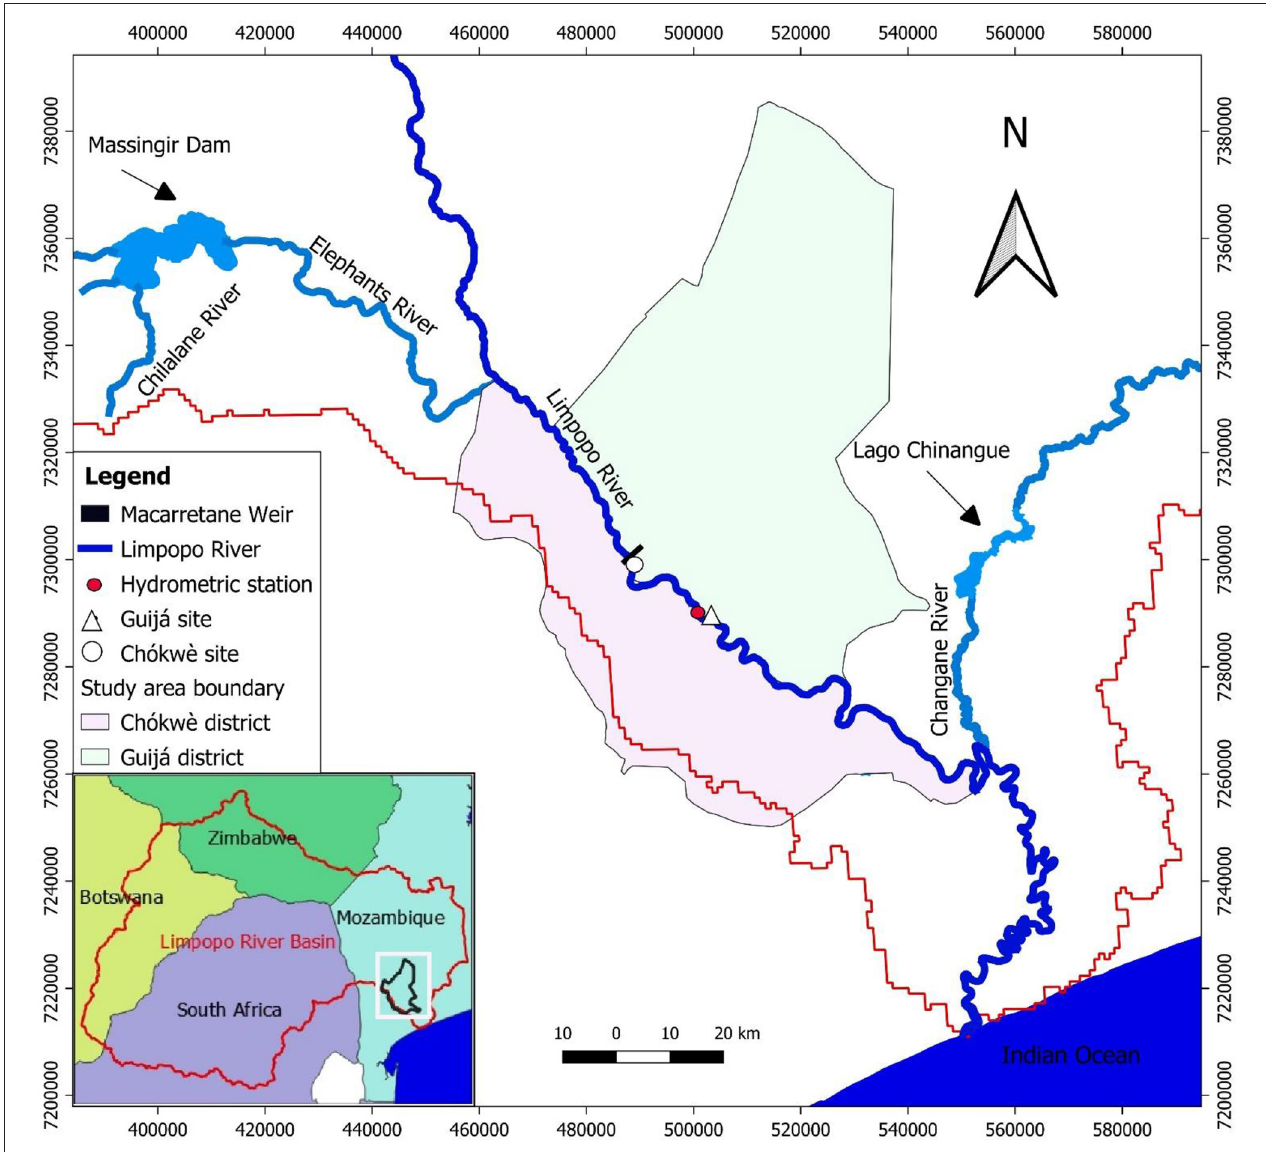
FIGURE 1 | Location of the study sites within the Limpopo River and corresponding